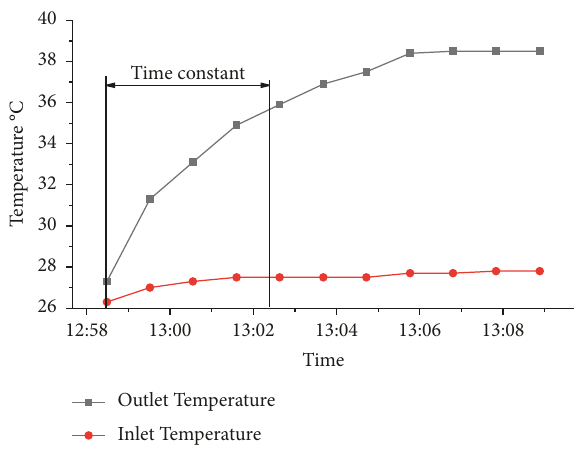
Figure 9: Evaluation of collector heating time.